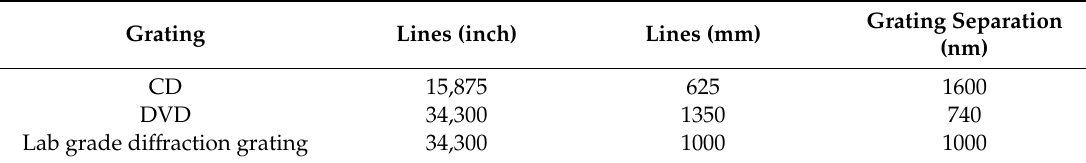
Table 1. Grating separation for di ff erent di ff raction